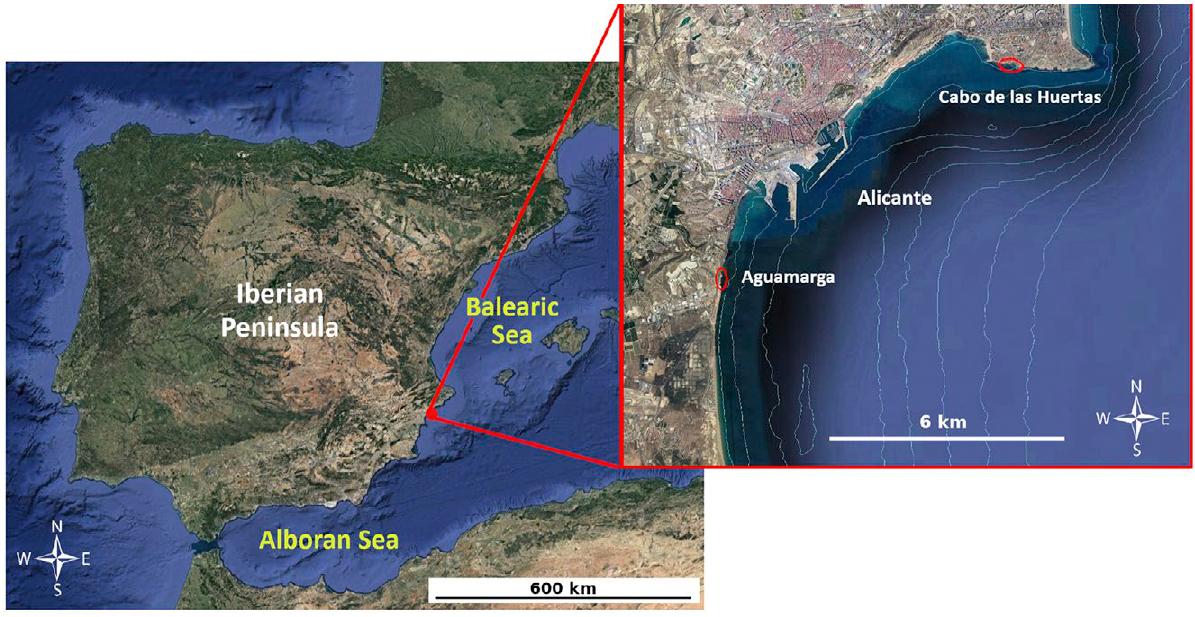
Fig. 1. – Study area showing the sampling locations: Cabo de las Huertas (the non-degraded location) and Aguamarga (the anthropogenic-de- graded location). Isobath interval is equal to five metres. Modified from Google